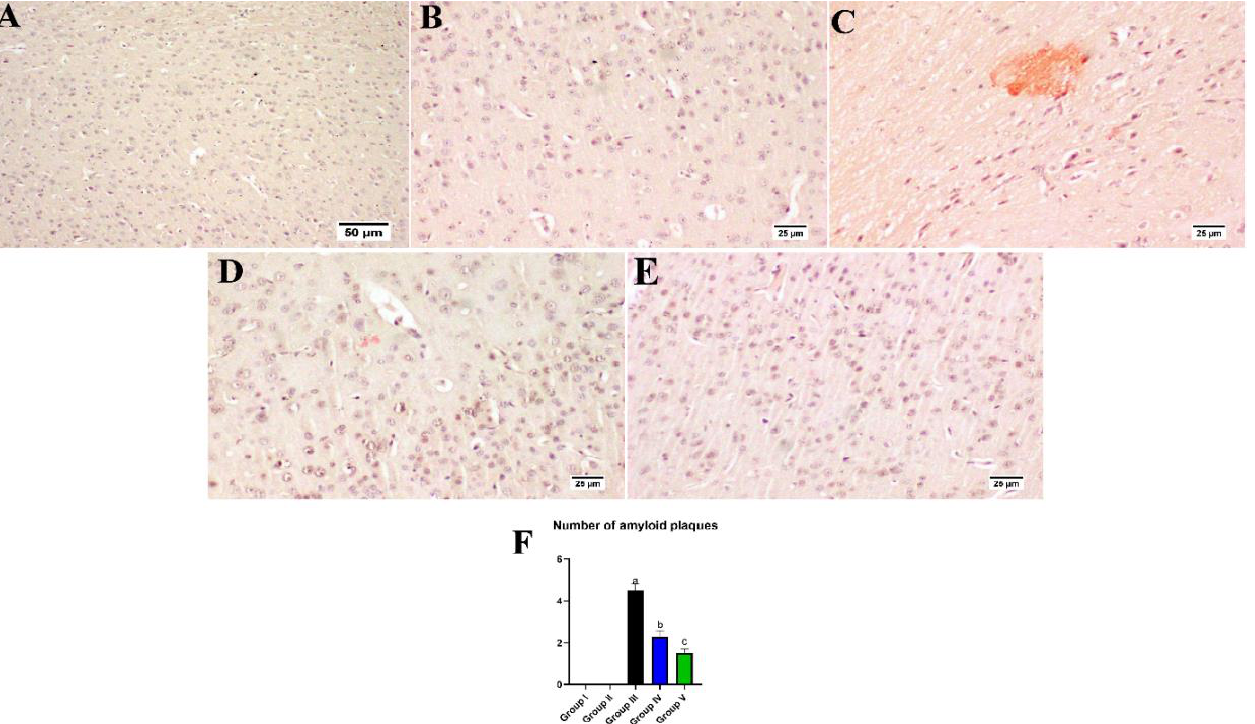
Figure 13. Effect of administration of umuhengerin on amyloid plaques number. Congo red stain was used for detection of amyloid plaques. Normal control mice showed an absence of amyloid deposition in the brain tissue whether in the ( A ) control group or ( B ) those injected with umuhengerin (groups I and II). ( C ) Amyloid deposition in the brain tissue were detected in group III, which received STZ injection. ( D ) Administration of umuhengerin resulted in a marked reduction in the number and size of amyloid plaques in the brain tissue. ( E ) Group V, which was injected with donepezil, showed few to an absence of amyloid plaques in most examined brain tissue sections. ( F ) Chart showing the number of amyloid plaques (high microscopic field) in different experimental groups. Values are expressed as mean ± SEM; n = 3. Different letters (a–c) above the error bar indicate statistically significant differences at p < 0.05.